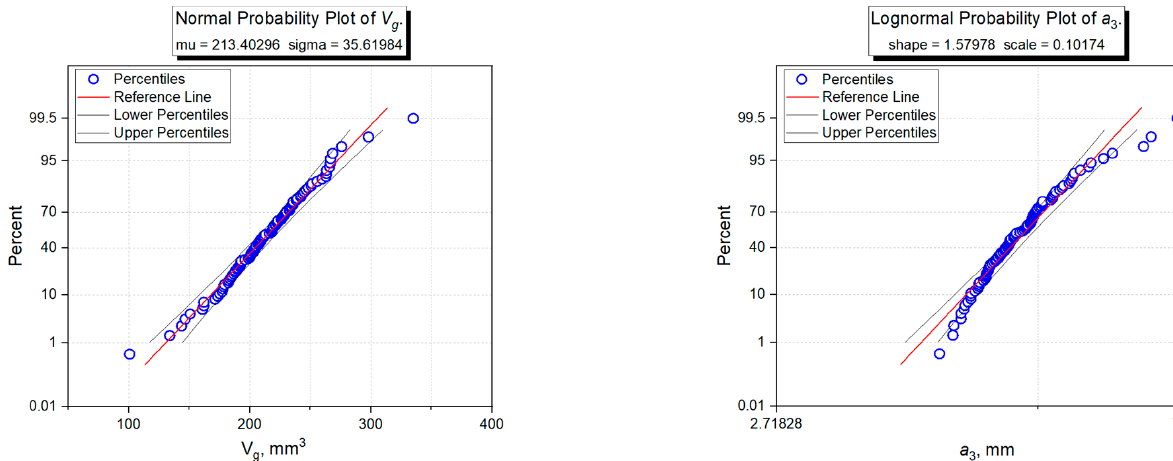
Figure 5. Probability plots of tested distributions fitted to empirical data of the selected physical properties of corn grain such as mass ( m ), true volume ( V t ), geometric volume ( V g ), length ( a 1 ), aspect ratio ( R a ), volume-equivalent sphere diameter ( D E ), width ( a 2 ), and height ( a 3 ). The blue point corresponds to the percentiles of empirical data. The red curve is the reference line for the tested distribution. The more empirical data are placed along the reference line, the better the theoretical distribution fits the experimental data.